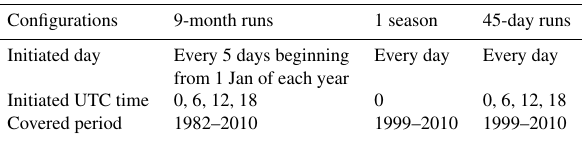
Table 1. Configurations of the CFSv2 hindcast. UTC stands for Co- ordinated Universal